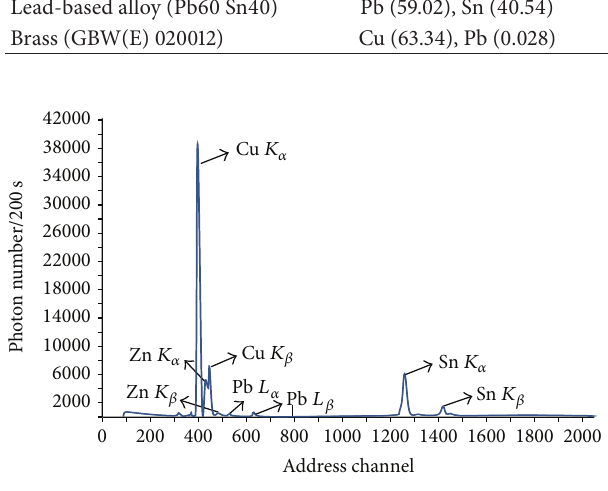
Figure 5: Spectral line of